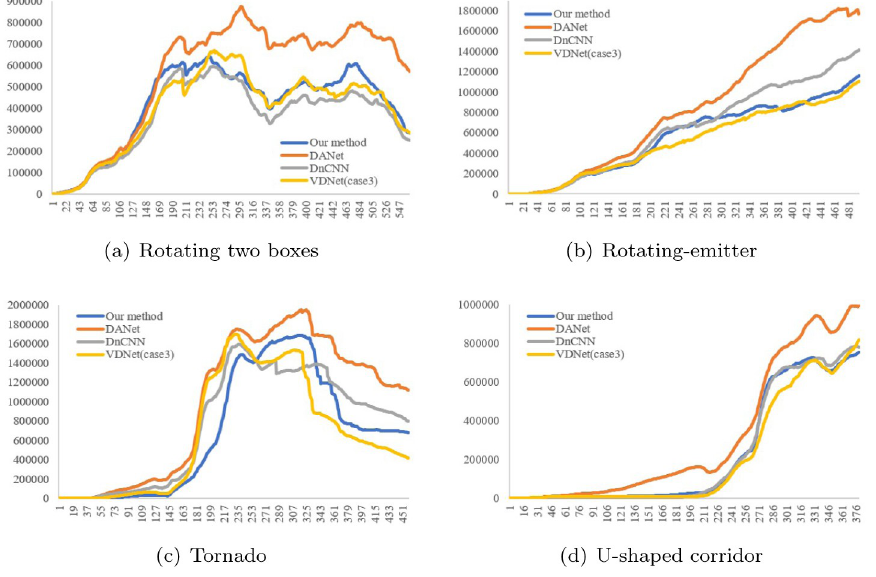
Fig 27. Comparison of foam particles (number) between the previous methods and our method. (a) Rotating two boxes, (b) Rotating-emitter, (c) Tornado, (d) U-shaped corridor.